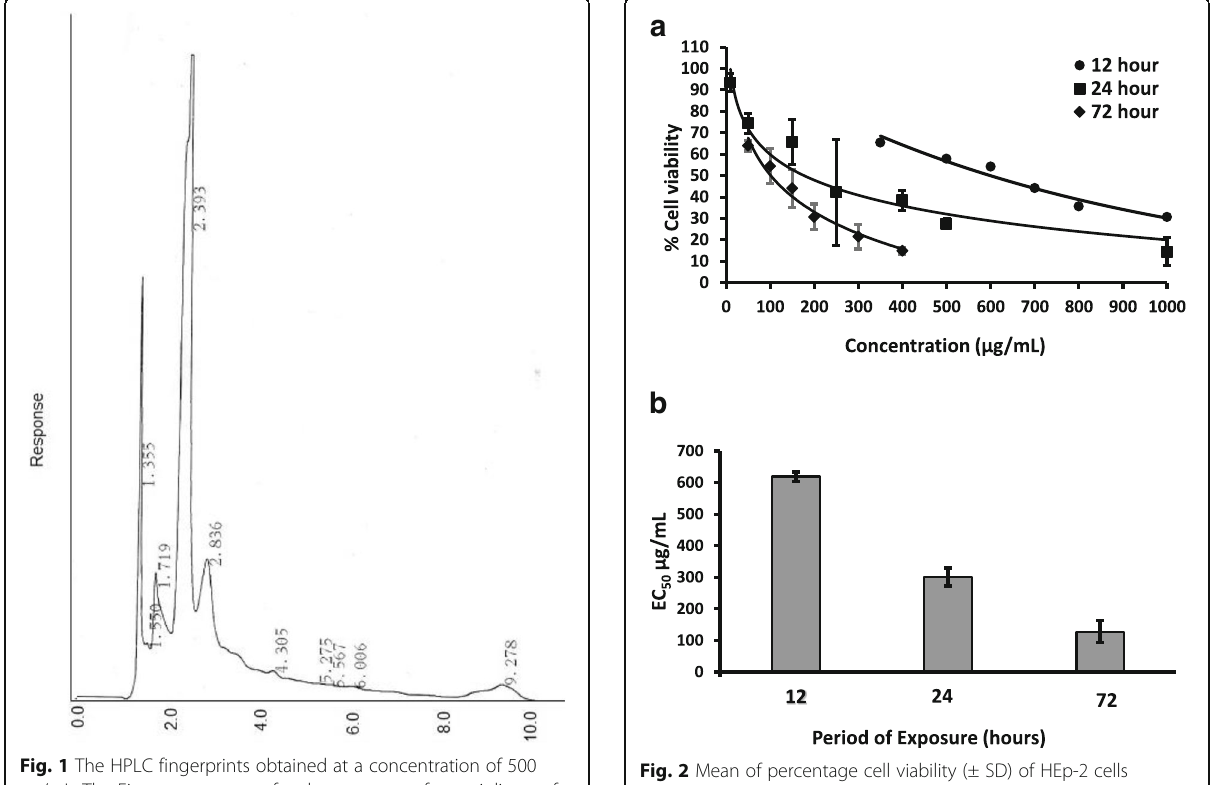
The percentage protein content of the cell lysate of treated cells to that of negative control was decreased linearly along with the concentration (Fig. 4). The EC obtained for SRB assay is shown in the Table 1. 50